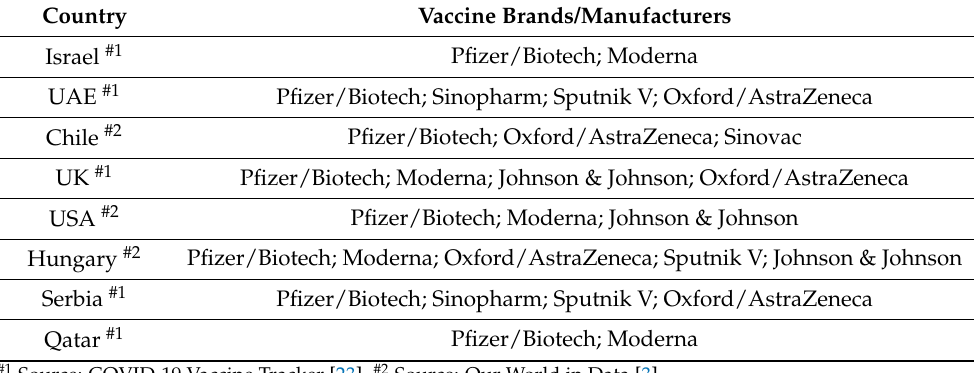
Table 4. The brand/manufacturers of vaccines used in these